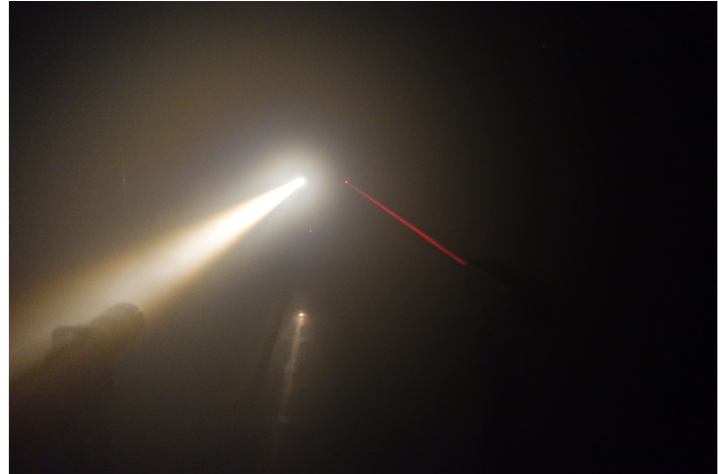
Figure 7. Spectral transmittance measurement experiment in fog.